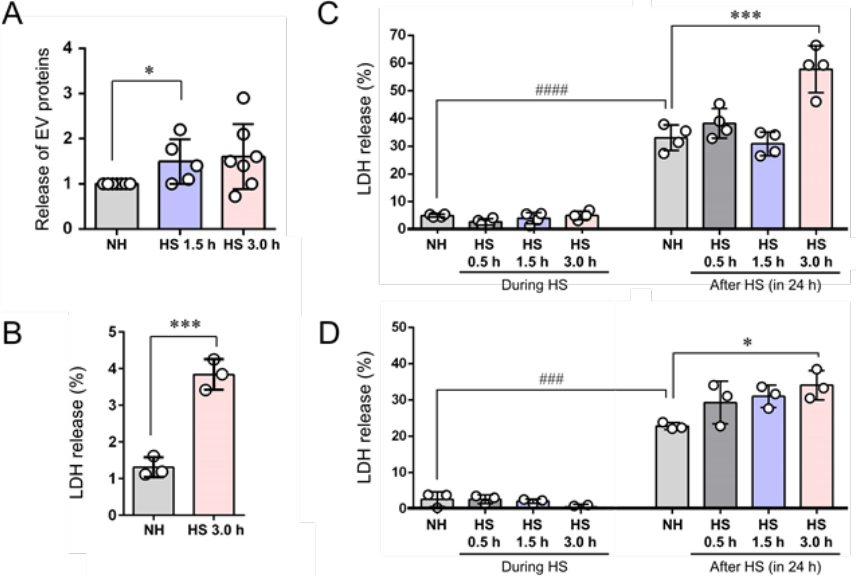
Figure 3. Release of EVs and membrane damage upon HSS. PC-3 cells were stimulated with HSS for 0.5, 1.5, or 3 h or NH, cultured for 24 h in serum-free media, from which EVs were then collected. ( A ) Release of EVs in response to stress. Protein concentrations of EV fractions were quantified using protein assay. The ratio compared to NH is plotted. * p < 0.05, n = 5 to 7. ( B ) Release of lactate dehydrogenase (LDH) upon HSS. PC-3 cells in the sparse condition were stimulated with or without HSS for 3 h and then LDH release was measured. ( C,D ) Column scatterplot analysis of LDH release. PC-3 cells were stimulated with HSS for 0.5, 1.5, or 3 h or NH, cultured for 24 h in serum-free media. The released LDH was measured. Data from two independent experiments are shown in C and D. Statistical analysis was carried out using ANOVA and Tukey’s multiple comparisons test. n = 3, *** p < 0.001, * p < 0.05, ### p < 0.001, #### p <